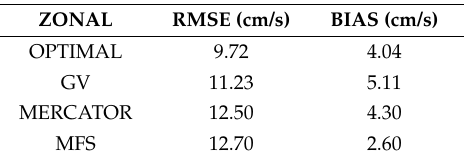
Table 1. BIAS and Root Mean Square Error (RMSE) between the Optimal-GV-MERCATOR-MFS and the High-Frequency Radar (HFR) surface currents in the Malta–Sicily Channel. Zonal Component.